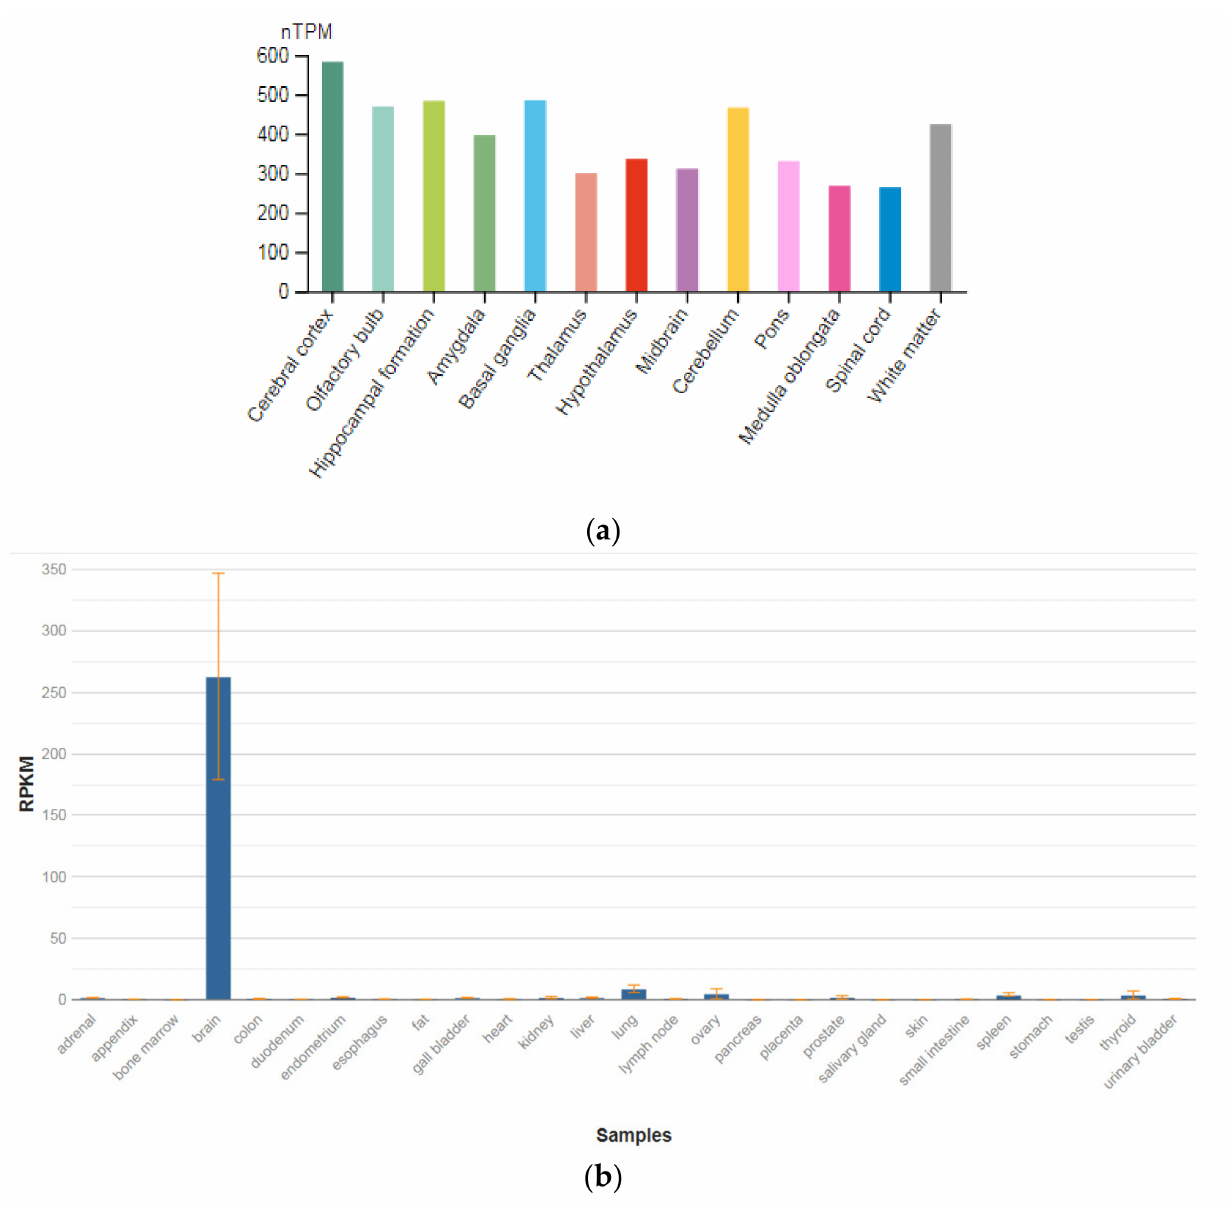
Figure 3. The tissue expression of the protein M6A in the brain ( a ) and other organs in the human body ( b